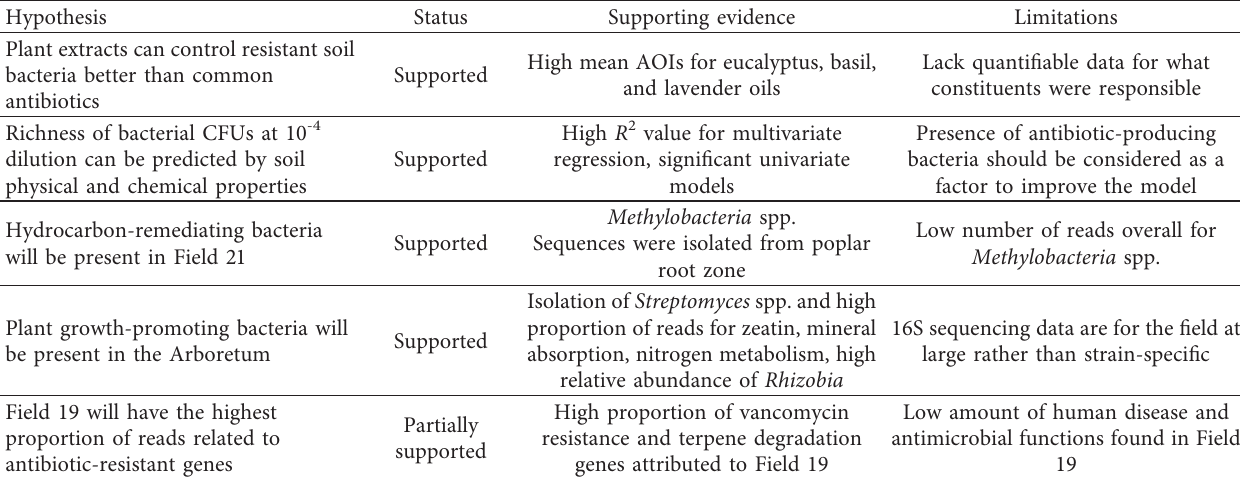
Table 6: Status of hypotheses at the conclusion of the 16St and soil classification